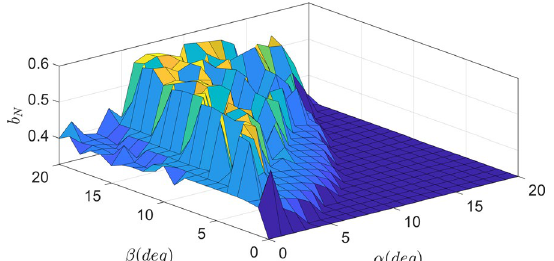
Fig. 16 Cost function values of GNVR shape